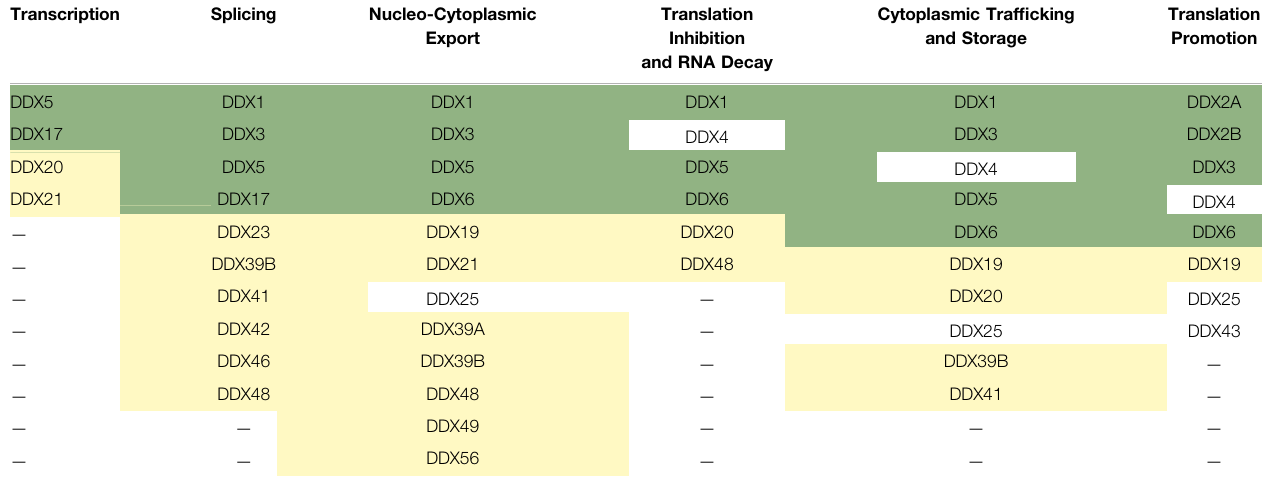
TABLE 1| List ofDEAD-box helicases involved in different steps ofgene expression. The proteins witha well-characterised role in HIV-1 replication are shaded ingreen and those that have been implicated in playing a role in viral replication are shaded in yellow.